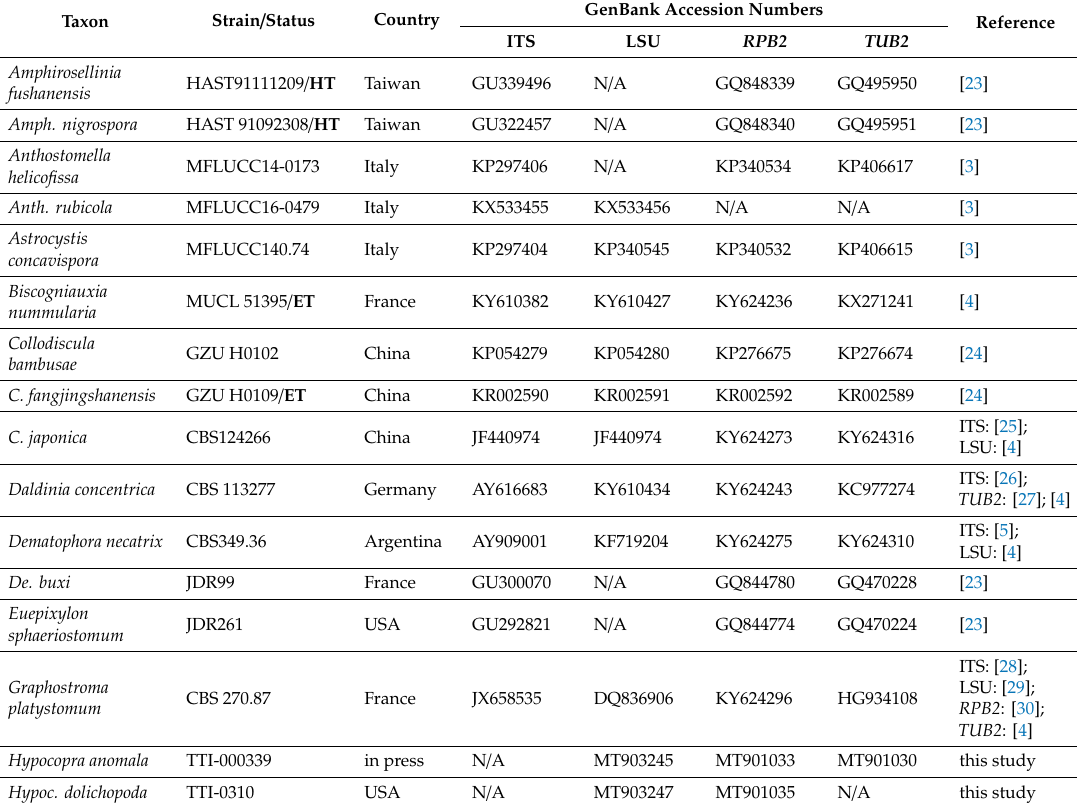
Table 1. List of all taxa used in the current study. ET (boldface) : epitype strain, HT (boldface) : holotype strain, PT (boldface) : paratype